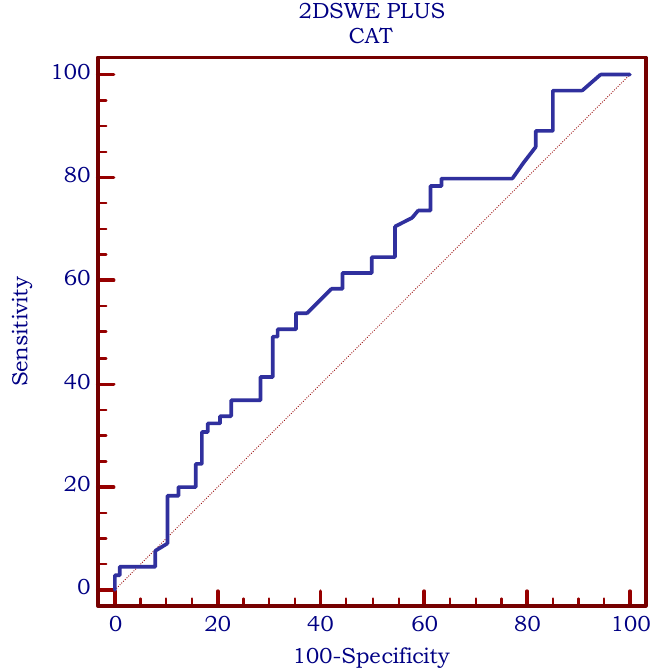
Figure 9. Diagnostic performance of 2D-SWE PLUS for predicting the need for levothyroxine sup- plementation in patients with chronic autoimmune thyroiditis (AUC = 0.59; cut-off value >24.5 kPa, sensitivity = 50.77%; specificity = 68.18%).